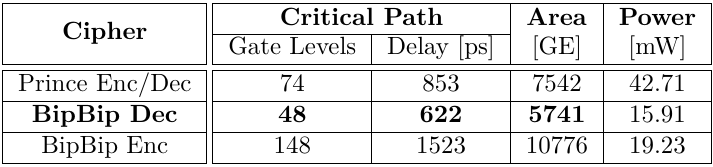
Table 9: Unrolled implementation results on Intel 10nm with 0 . 85 V and 100°C.